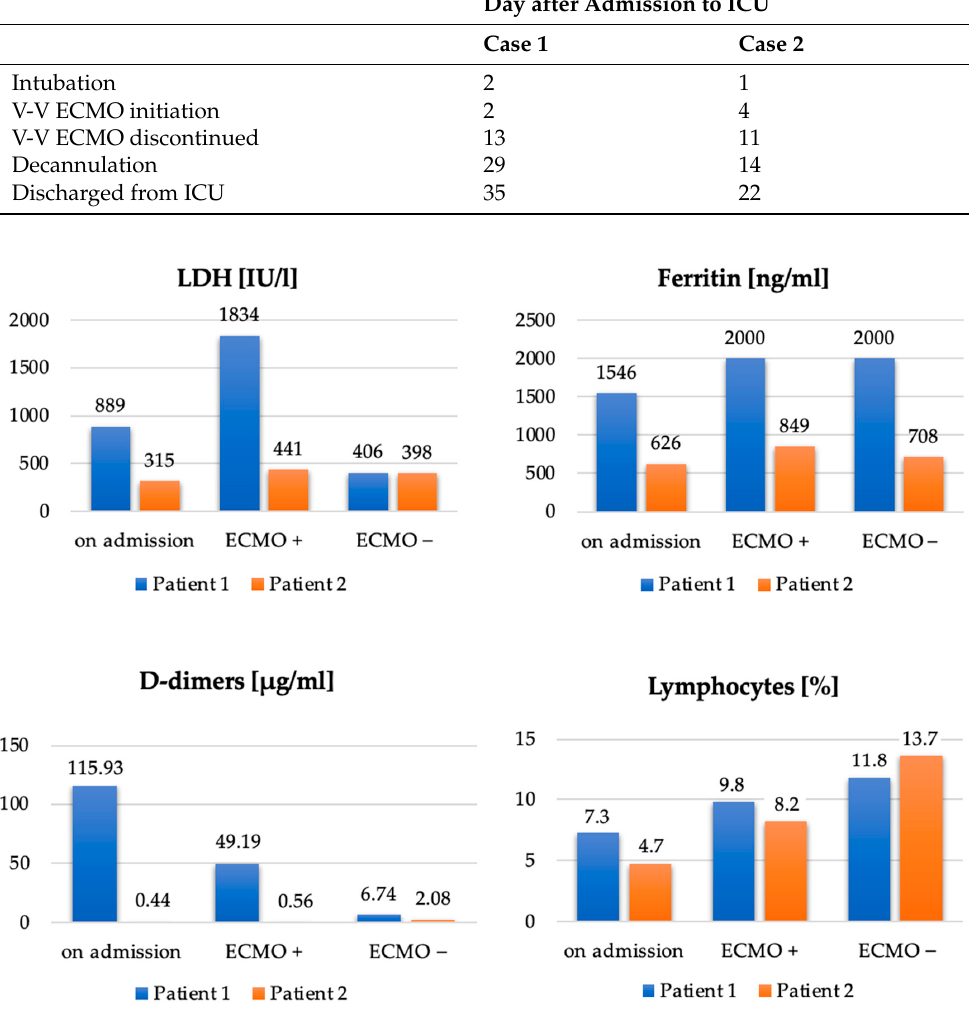
Figure 5. Comparison of LDH [IU/L], ferritin [ng/mL], D-dimers [µg/mL] and lymphocytes [%] in Patient 1 and Patient 2, on admission to the ICU, after initiation of ECMO (ECMO+) and on discontinuation of ECMO (ECMO–).